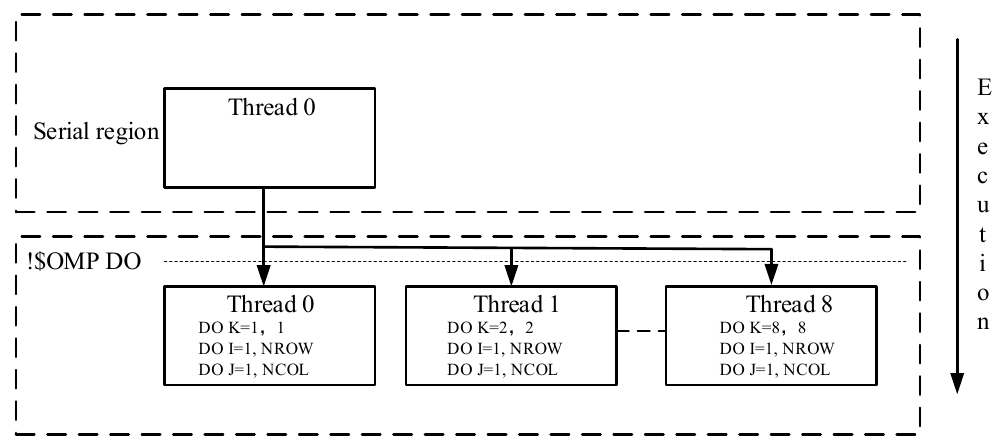
Figure 2. The parallelization of the three-level nested DO-Loop in case of the number of layers > number of processors.